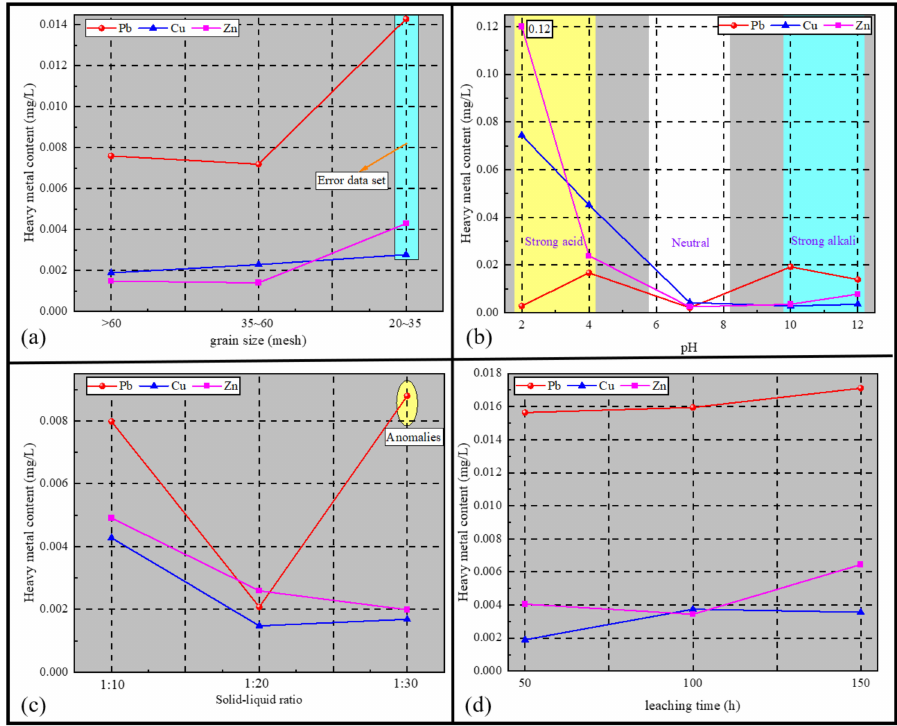
Figure 10. Static leaching test results: ( a ) Heavy metal content versus grain size curve, ( b ) Heavy metal content versus leachate pH curve, ( c ) Heavy metal content versus Solid-liquid ratio curve, ( d ) Heavy metal content versus leaching time